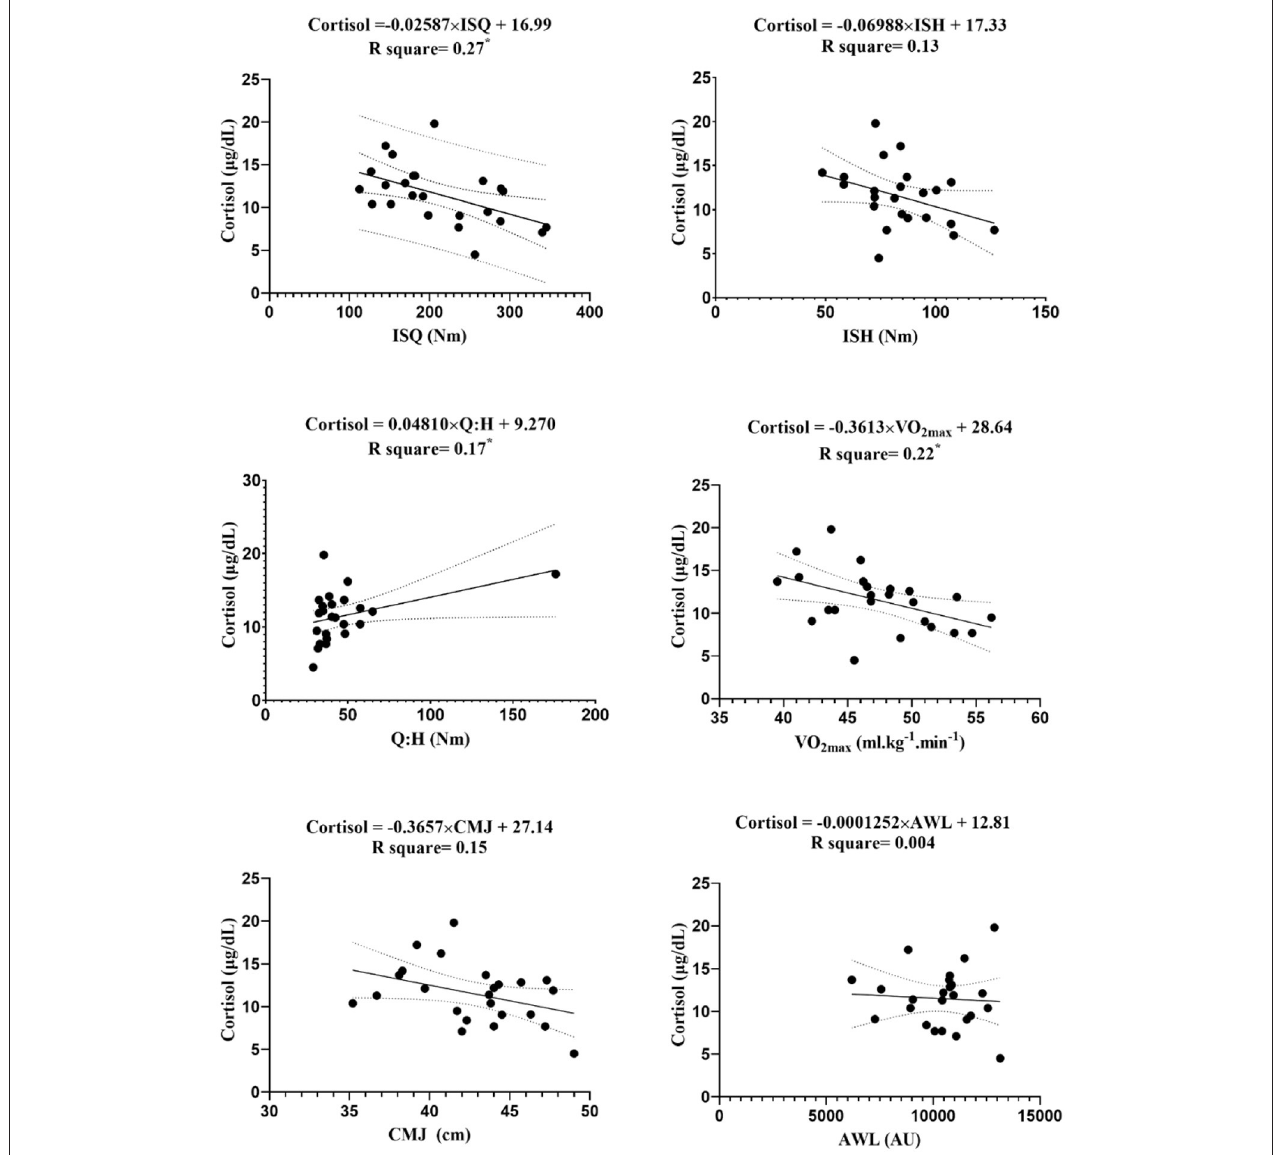
FIGURE 5 | Regression analysis to explain fitness levels and AWL (the average of the three stages) with cortisol; ISH, isometric muscular strength of the hamstring muscles; ISQ, isometric muscular strength of the quadriceps muscles; H:Q, the strength of isometric quadriceps to hamstring ratio; VO 2max , maximal oxygen uptake; CMJ, countermovement jump; AWL, accumulated workload training; Nm, Newton meter; AU, arbitrary unit. * Significant differences p ≤